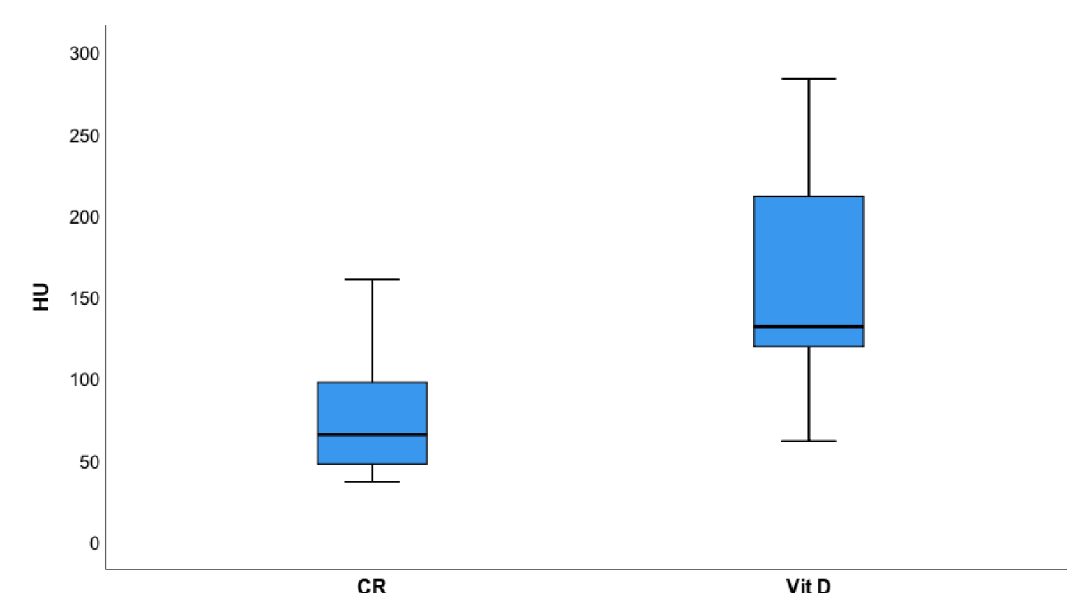
Figure 4. Plaque density (Hounsfield Units, HU) was significantly ( p < 0.001) higher in those receiving vitamin D (Vit D) supplements as compared to controls (CR) indicating higher calcified plaque component.